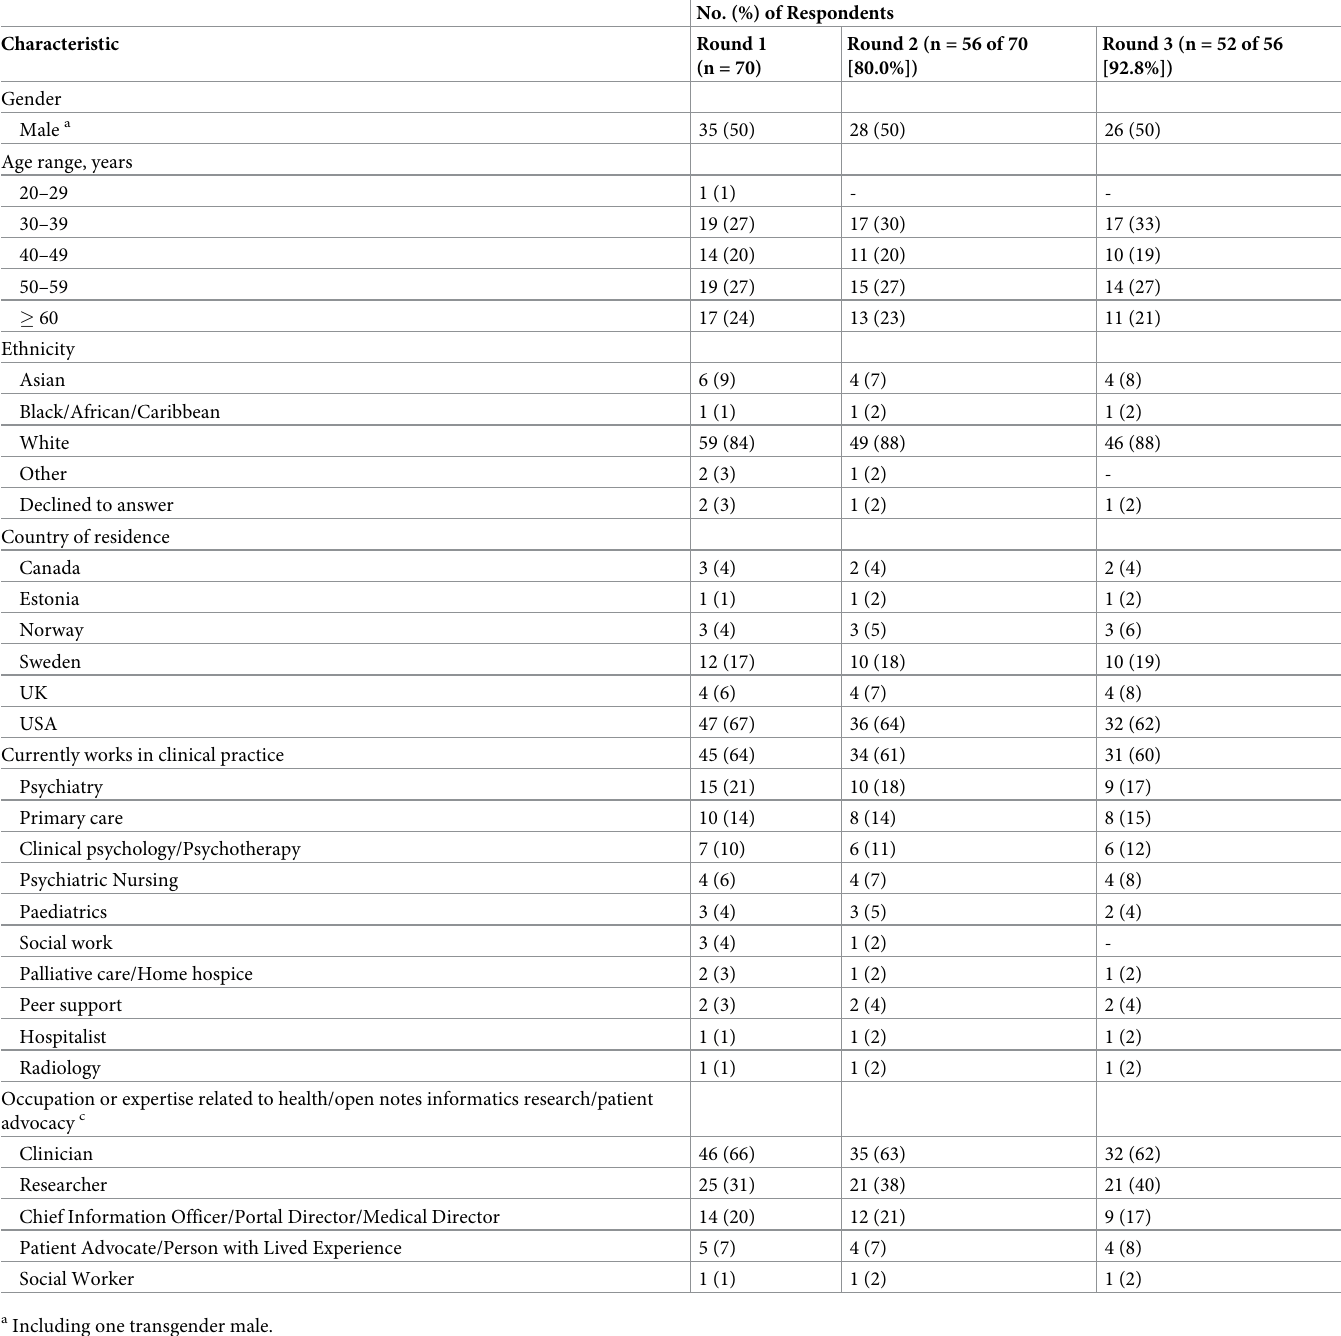
Table 1. Characteristics of survey respondents by